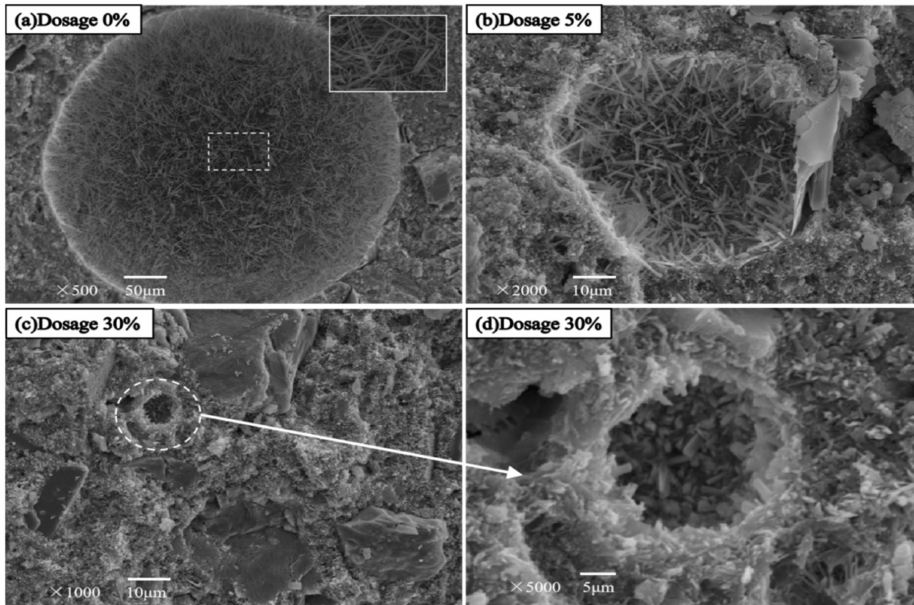
Figure 6. SEM images of MOC in air (( a – d ) in the figure represent the incorporation amount of lithium slag as 0%, 5%, 30% and 30% respectively).